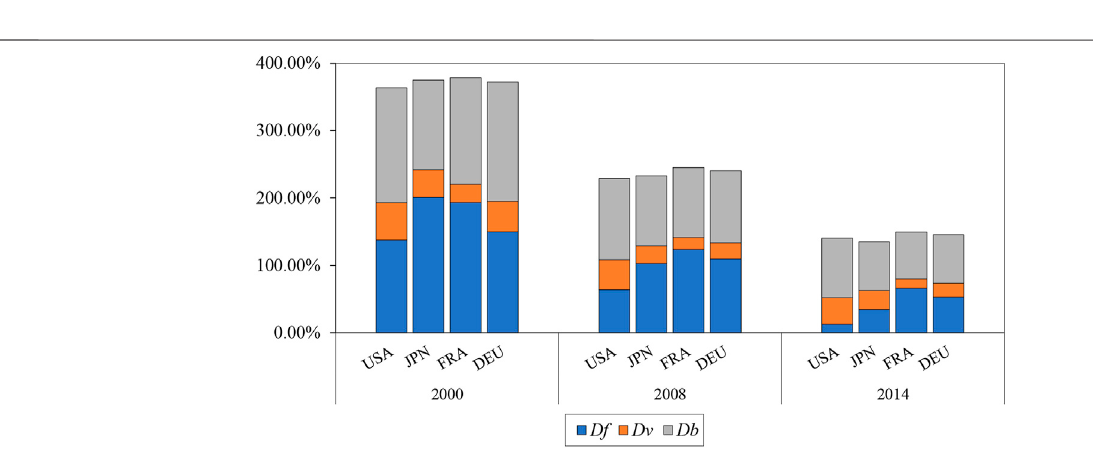
Frontiers in Environmental Science |